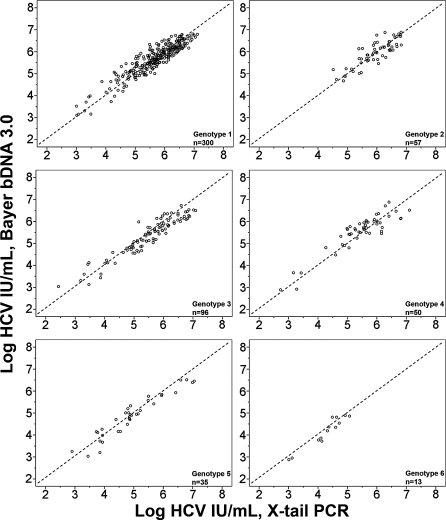
Correlation of Viral Loads as Determined by X-Tail RT-PCR (x-Axis) and bDNA (y-Axis)Genotypes and numbers of samples (n) are given in the bottom right corner of each panel. Pearson's bivariate correlation coefficients were 0.92, 0.85, 0.95, 0.91, 0.95, and 0.96 for HCV genotypes 1 to 6, respectively. The dashed lines represent ideal correlations. Genotype 5, 0.07/0.31; and genotype 6, 0.12/0.19.